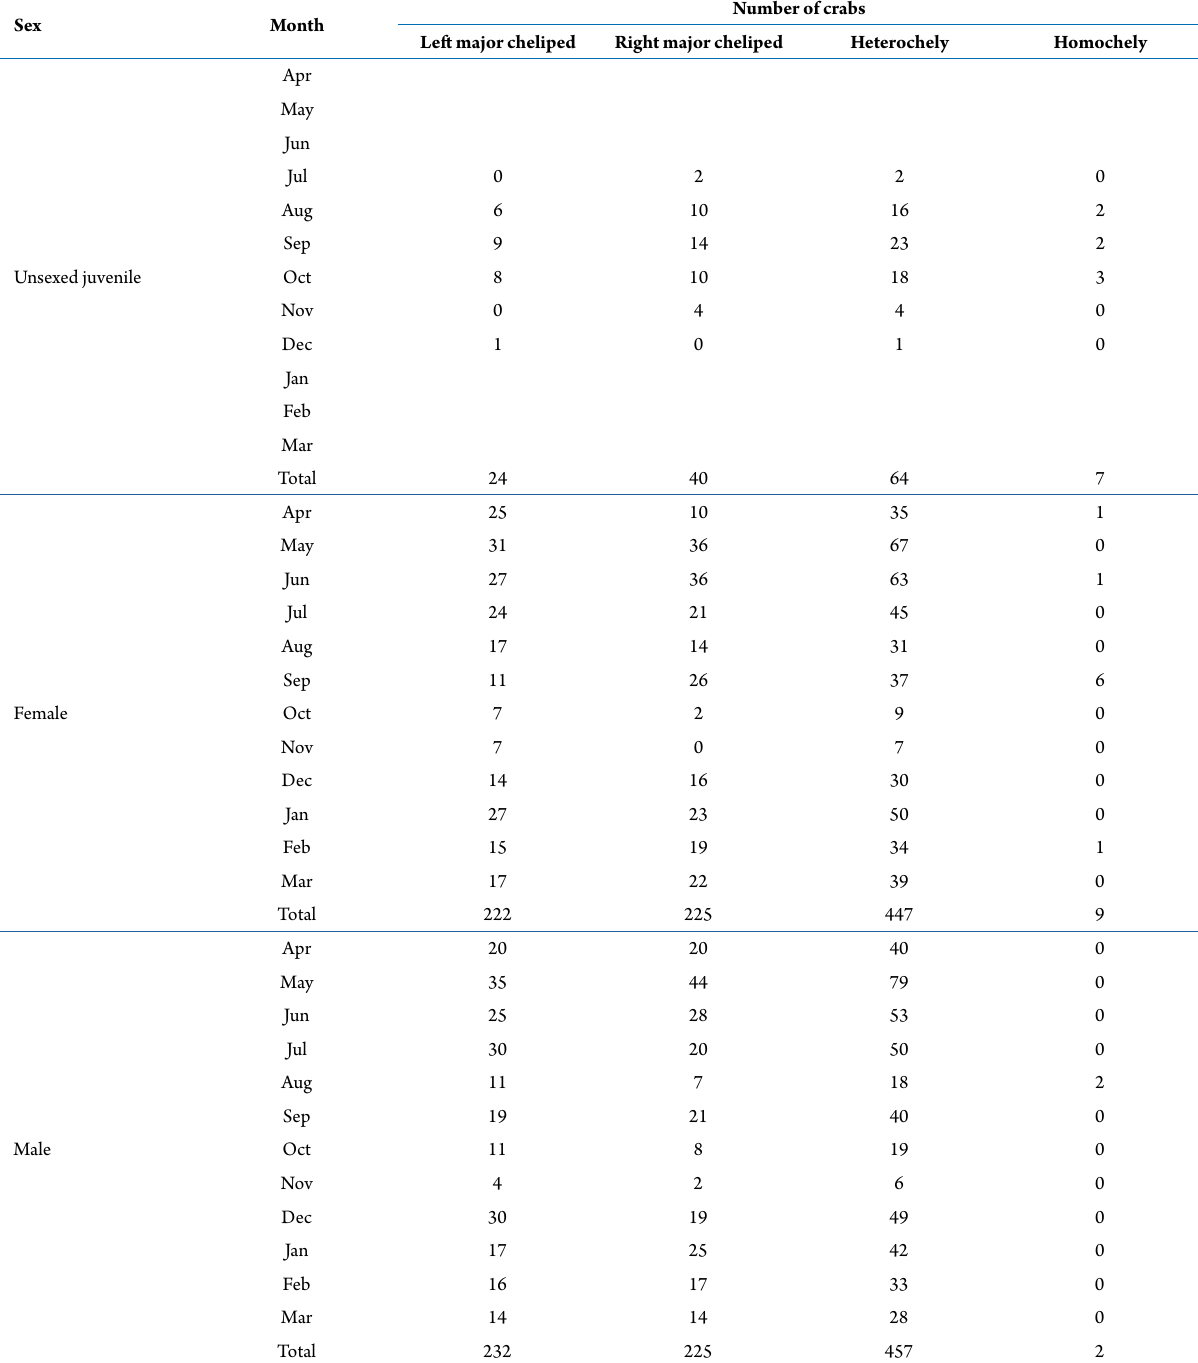
Table A1. Cheliped laterality of the porcellanid crab Petrolisthes japonicus collected from April 2008 to March 2009. Numbers of crabs with heterochely (either the left or right major chelipeds) and homochely (identical sized left and right chelipeds) are summarized. Number of crabs Sex Month Left major cheliped Right major cheliped Heterochely Homochely